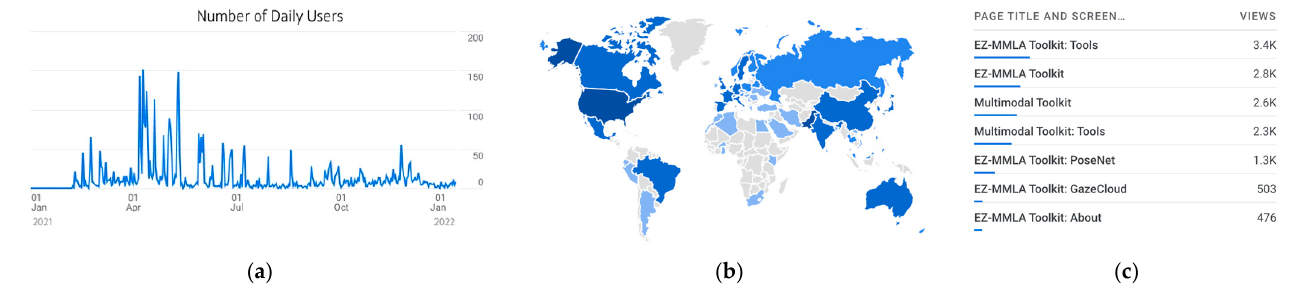
Figure 7. The mmla.gse.harvard.edu website receives frequent daily visits ( a ) from 66 countries all over the world ( b ). The main tools being used are PosetNet and GazeCloud ( c ).